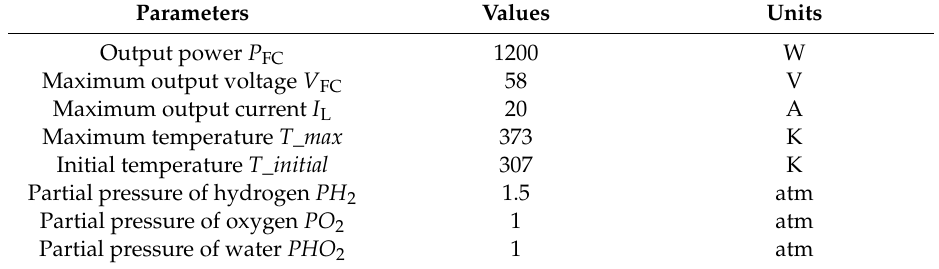
Figure 8. Worldwide harmonised light vehicle test procedure (WLTP). Table 3. Fuel cell parameters table in simulation.